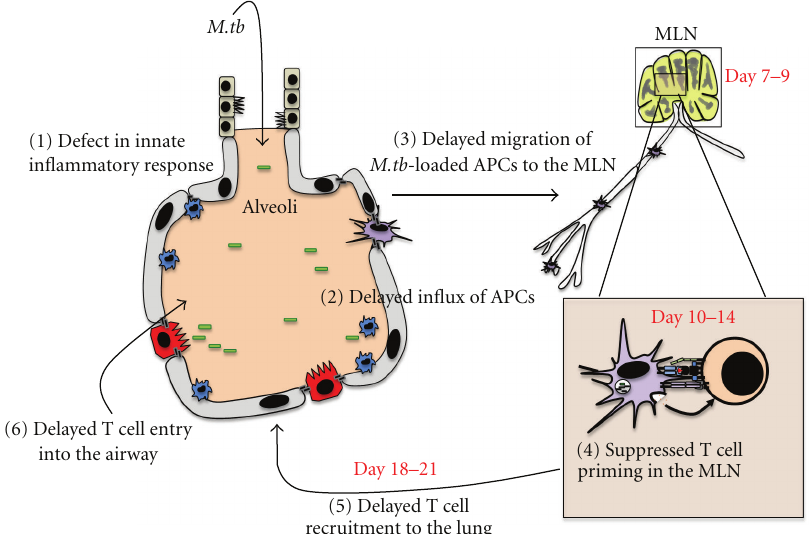
Figure 2: Illustration of the speculated major immunologic setbacks seen in the early course of pulmonary M.tb infection. The major defects are numbered in the diagram according to the sequence of events. APC: antigen-presenting cells; MLN: mediastinal lymph